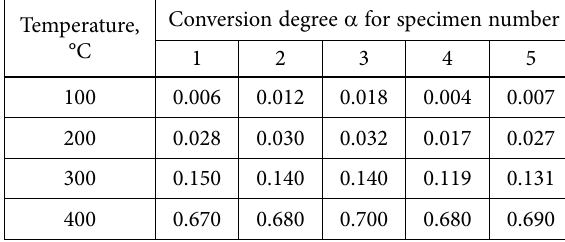
Fig. 3. TG curves for GFRP rod